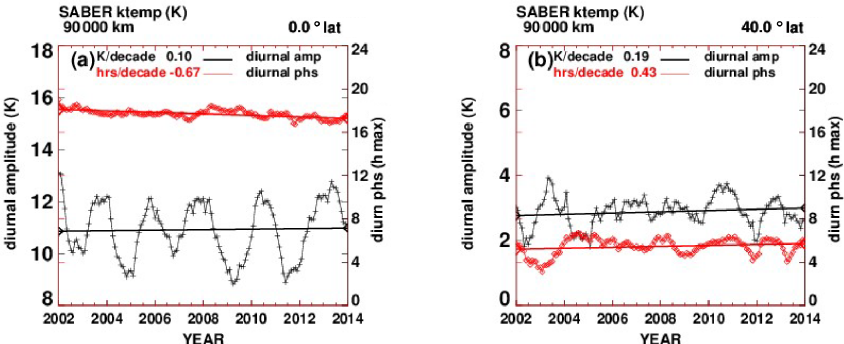
Figure A5. (a) Temperature tidal diurnal amplitudes and phases at 90km and the Equator. On the left axis scale, black line: tidal diurnal amplitude (K). On the right axis scale, red line: diurnal phase (h of maximum value). (b) As in (a) but at 40 ◦ N